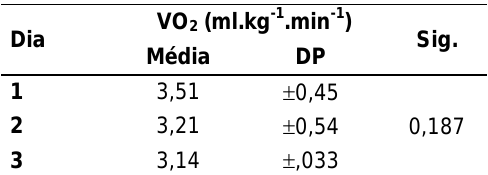
), percentual do consumo 2